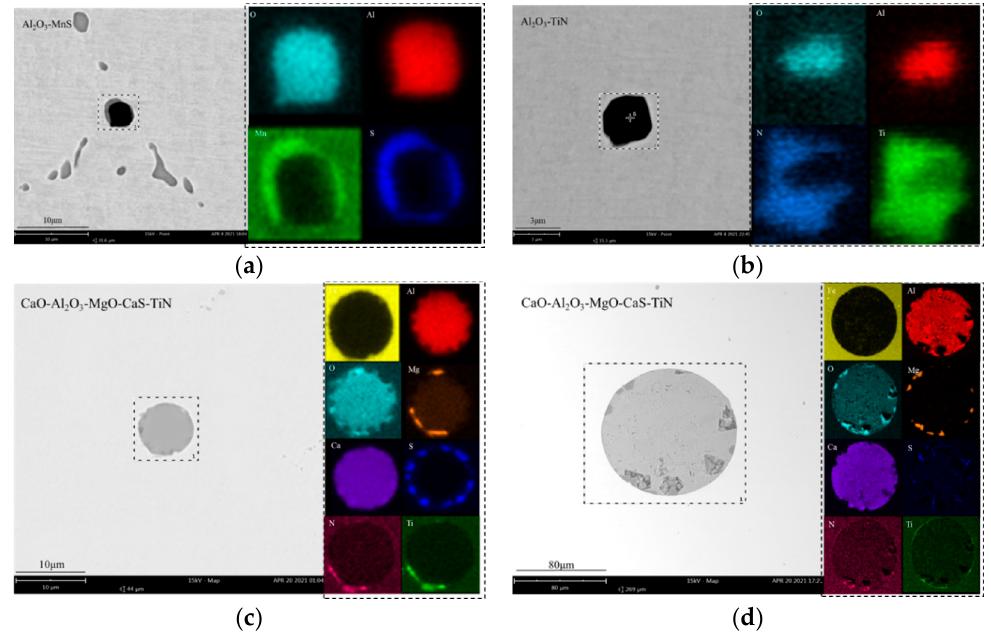
Figure 3. SEM surface morphology image with EDS elemental mapping analysis: ( a ) LF1; ( b ) LF2; ( c ) LF3; ( d ) LF4.